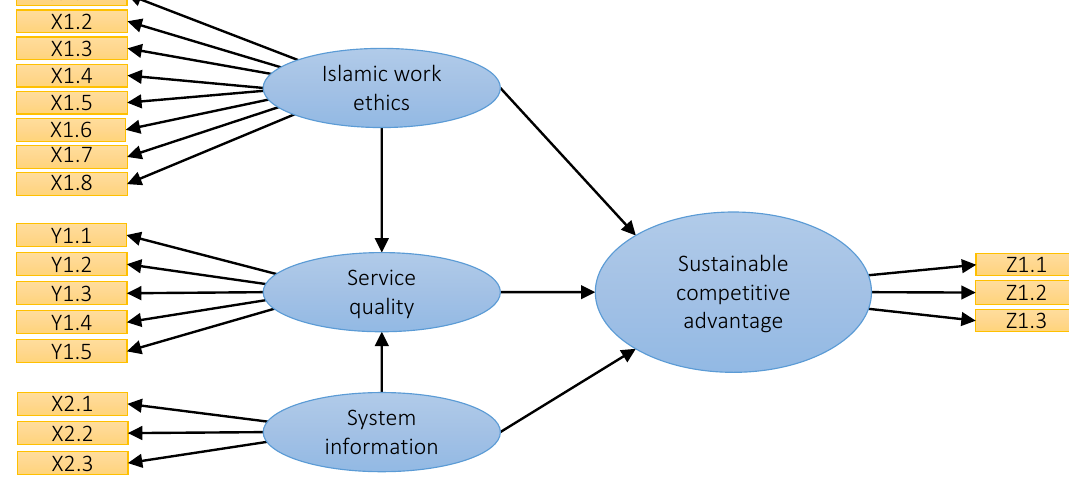
Figure 1. Research